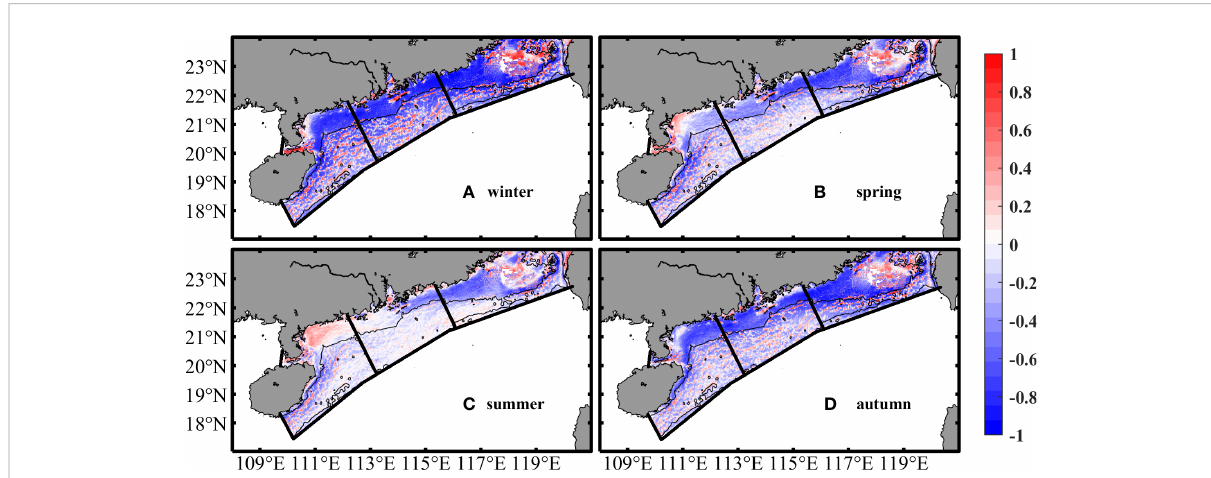
FIGURE 4 Seasonal distribution of cold and warm fronts averaged over 2002-2021 for (A) winter(January-March), (B) spring(April-June), (C) summer (July- September), and (D) autumn (October-December). Blue (red) represent cold(warm) fronts.The black lines are the 50-m and 200-m